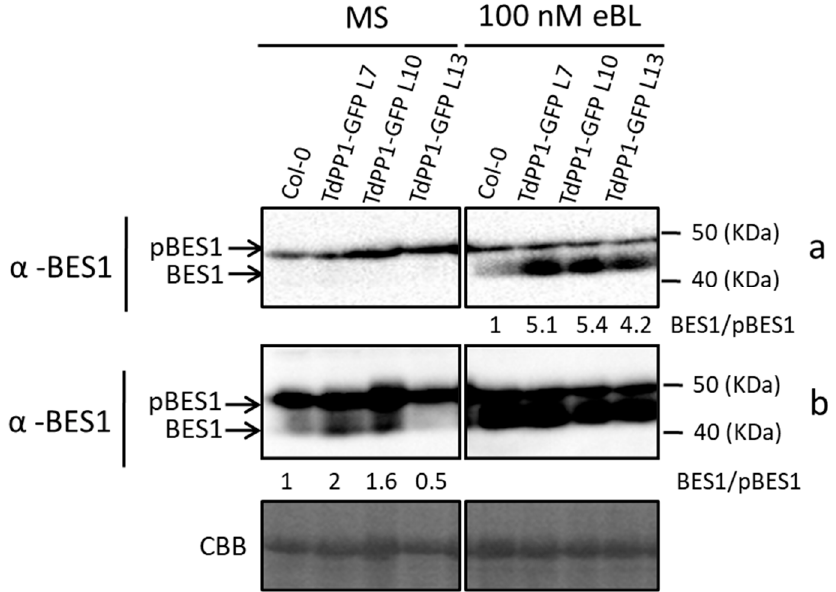
Figure 4. TdPP1 overexpression interferes with the balance pBES1/BES1. Phosphorylation status of BES1 in TdPP1-GFP OE lines in response to exogenously applied eBL. Protein extracts of 7-day-old seedlings (WT, L7, L10 and L13) treated or not for 1 h with 100 nM eBL were analyzed by an immunoblot assay with a specific anti-BES1 antibody. Upper arrow indicates phosphorylated BES1 (pBES1) and lower arrow indicates dephosphorylated BES1 (BES1). ( a ) Standard exposure of the blot ( b ) exposure with increased sensitivity. CBB: Coomassie Brilliant Blue. Numbers below blots represent the ratio of unphosphorylated BES1 (BES1) to phosphorylated BES1 (pBES1).